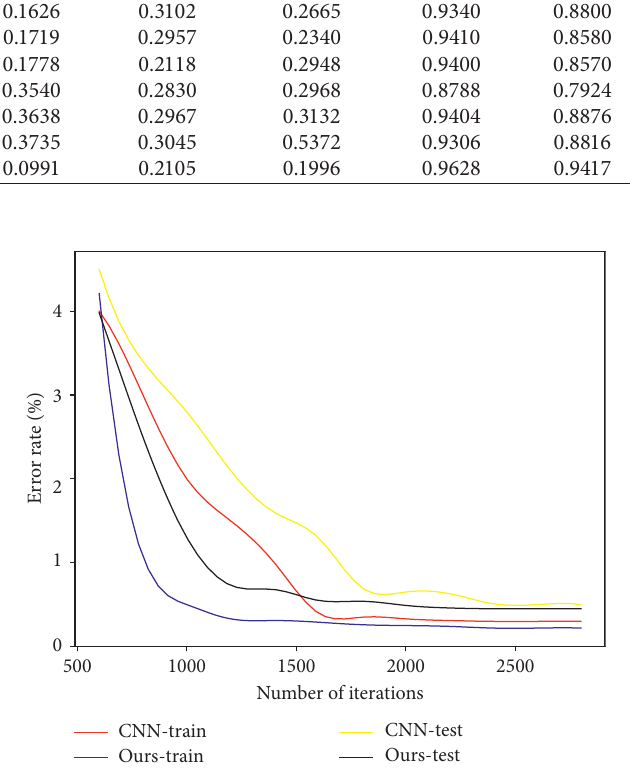
Figure 6: Relationship between iteration number and